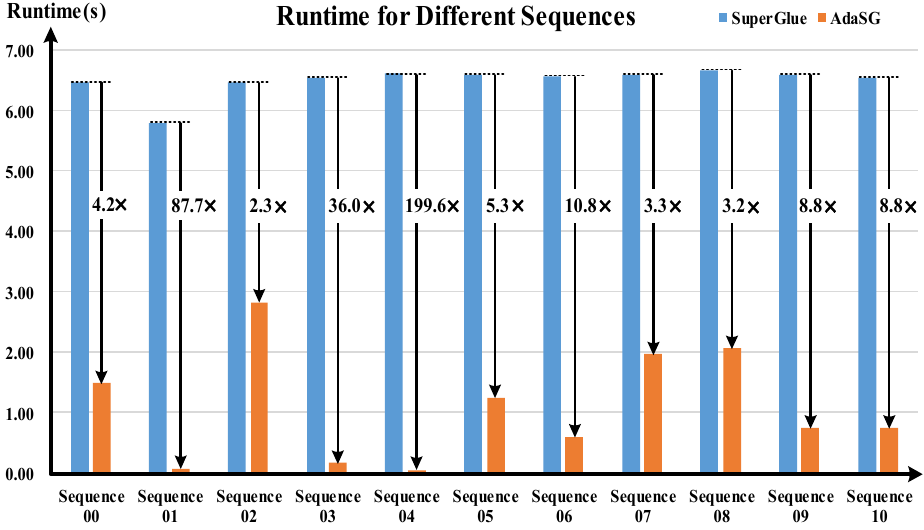
Figure 15. The runtime for different sequences of KITTI.